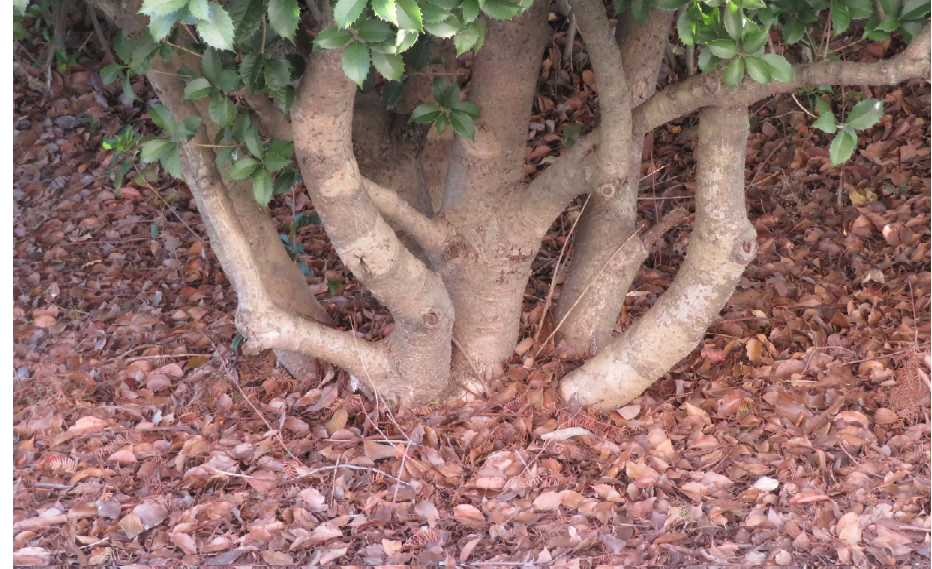
Figure 2. The accumulation of the fallen leaves on the soil under the tree of O. × fortune .